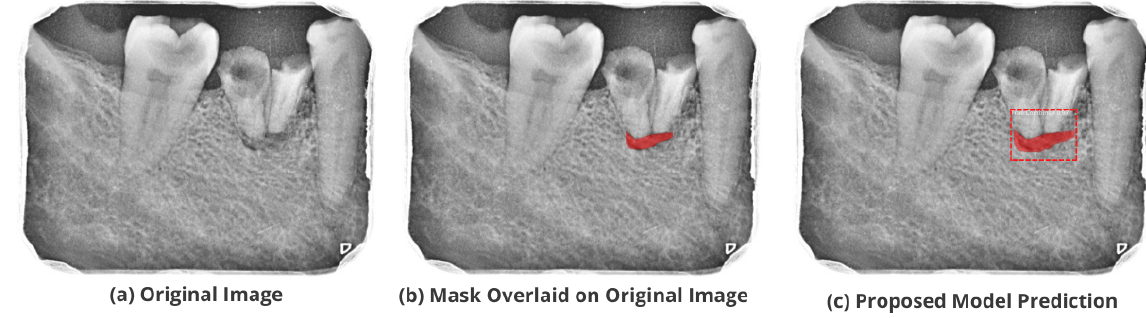
Figure 14. Test performance for the localization of ’True Combined’